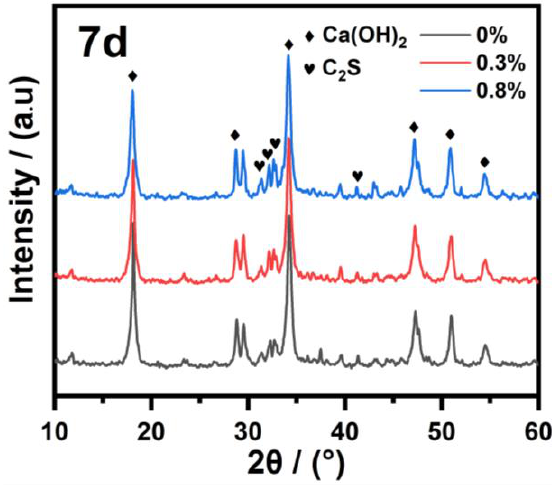
Figure 12. XRD patterns of NHL pastes with different IBMA content after 7 days of curing.